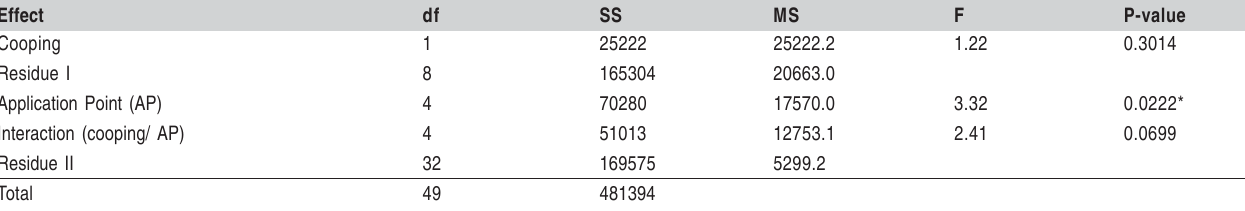
Table 1 – Results of two-way analysis of variance for conditional experiments.